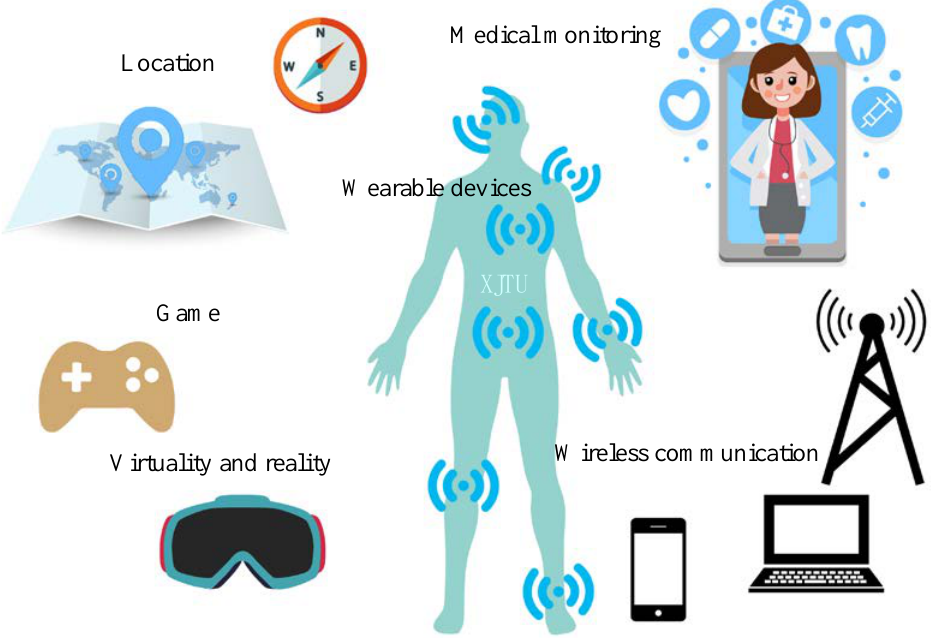
Figure 1. A Wireless Body Area Network (WBAN) and its applications [1,8,9–16].